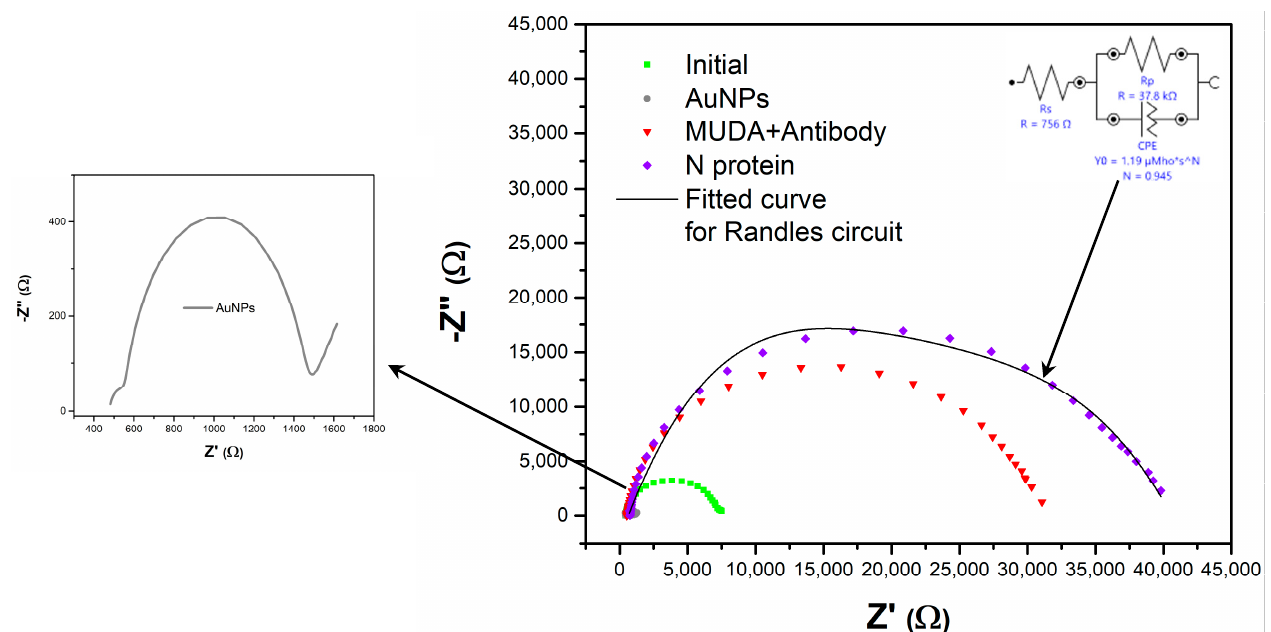
Figure 6. Nyquist diagram for the S6/02.08 sensor (WE area = 12.6 mm 2 ) with measurements after AuNP decoration, MUDA functionalization + antibody immobilization (one step), and N-protein binding.